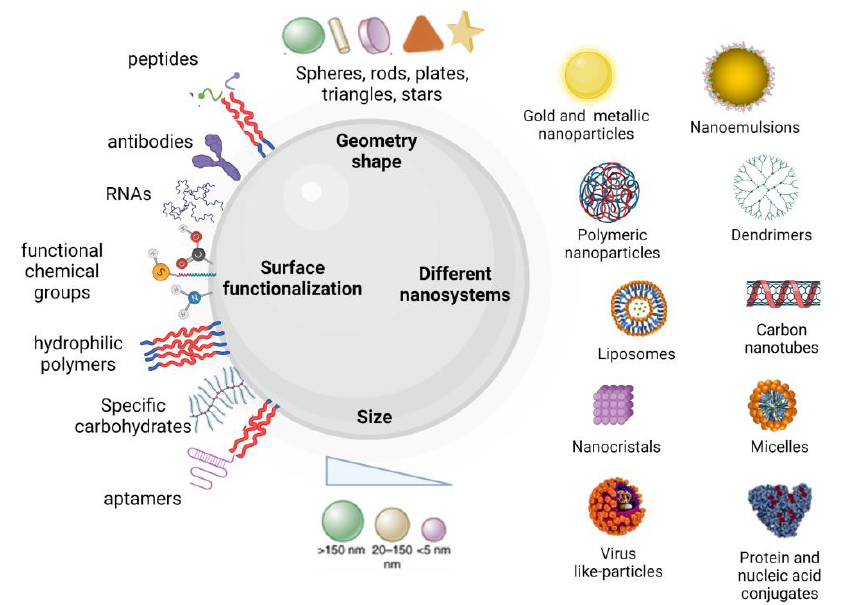
Figure 1. Schematic representation of the usual size, morphology, surface chemistry and types of nanomaterials employed in cancer therapy.